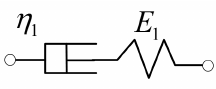
Figure 2. Maxwell Figure 2. Maxwell model.